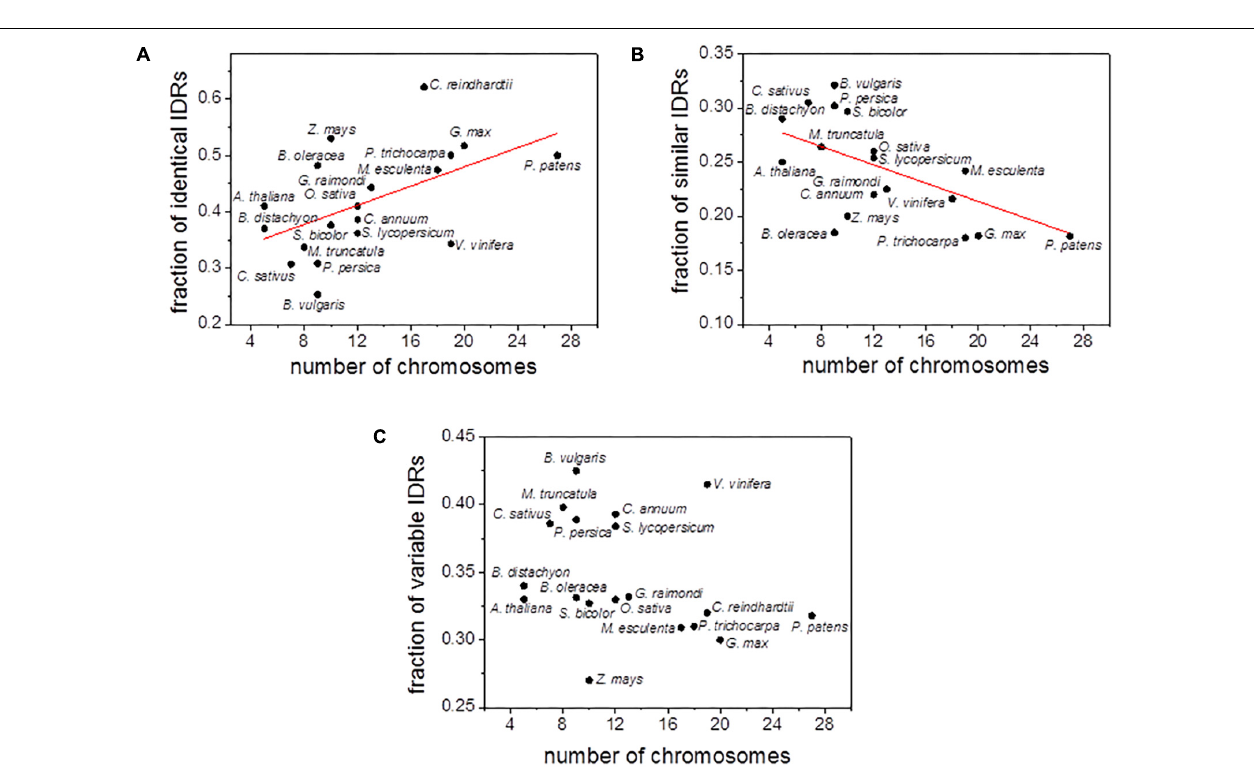
FIGURE 3 | Scatter plots of chromosome numbers versus the fraction of aligned identical IDRs (A) , similar IDRs (B) , variable IDRs (C) for C. reindhartii ( n = 17), P. patens ( n = 27), Z. mays ( n = 10), S. bicolor ( n = 10), O. sativa ( n = 12), B. distachyon ( n = 5), G. max ( n = 20), P. trichocarpa ( n = 19), B. oleracea ( n =